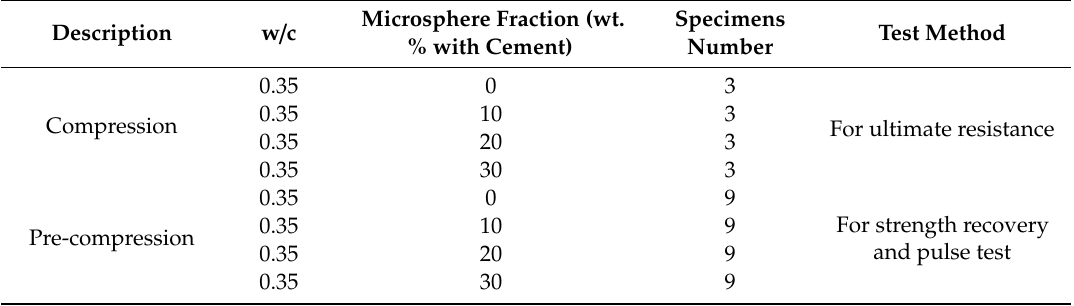
Table 4. Mixture proportion for